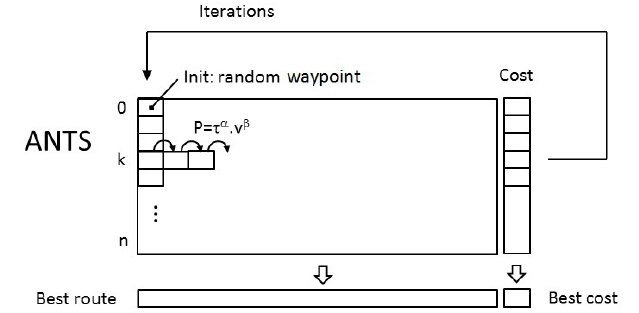
Figure 12. Principle of the ants colony